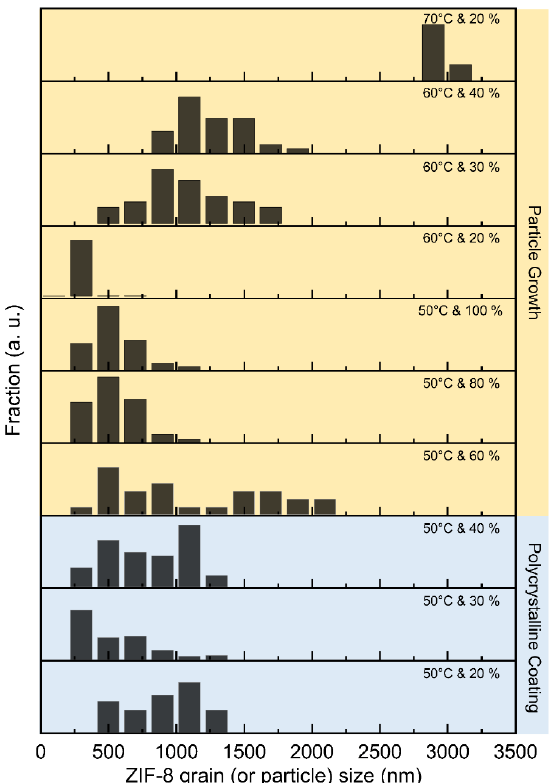
Figure 4. ZIF-8 grain (or particle) size distribution depending on the temperature and relative humidity. Because crystallinity of ZIF-8 was not high at the relative humidity (30 and 40%) and 70 °C, the grain size was not measured.